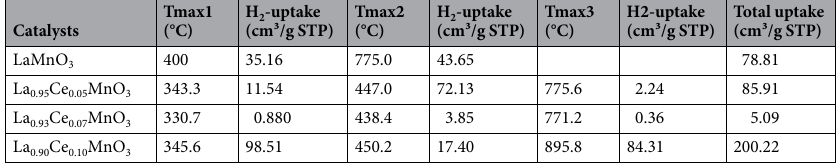
Table 2. H 2 consumption of La 1 − x Ce x MnO 3 perovskite